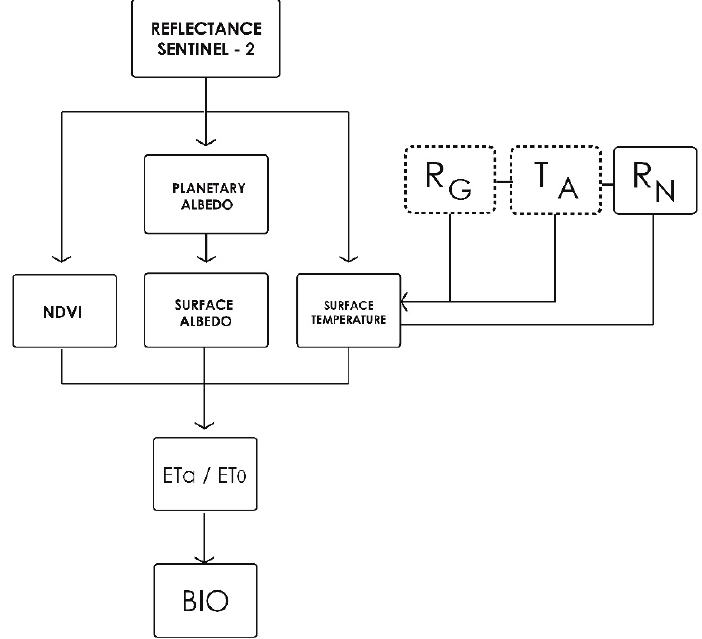
Figure 3. Flowchart for the large-scale radiation balances (net radiation, RN), crop coefficient ( ET a / ET 0 ), and biomass production (BIO) by applying the SAFER (Simple Algorithm for Evapotranspiration Retrieving) and Monteith method using Sentinel-2 images together with agrometeorological data (solar radiation, R G ; average air temperature, T A ; and reference evapotranspiration, ET 0 ).